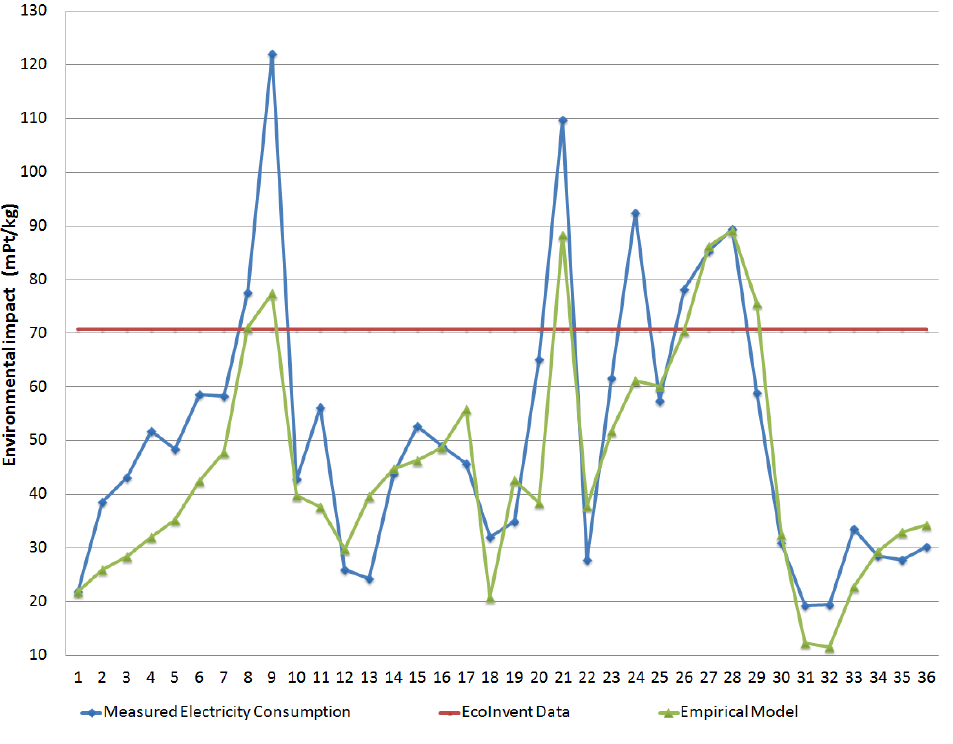
Figure 3. Comparison of modeled, measured, and EcoInvent data for the environmental impact assessment (ReCiPe). Materials 2018 , 11 , x FOR PEER REVIEW